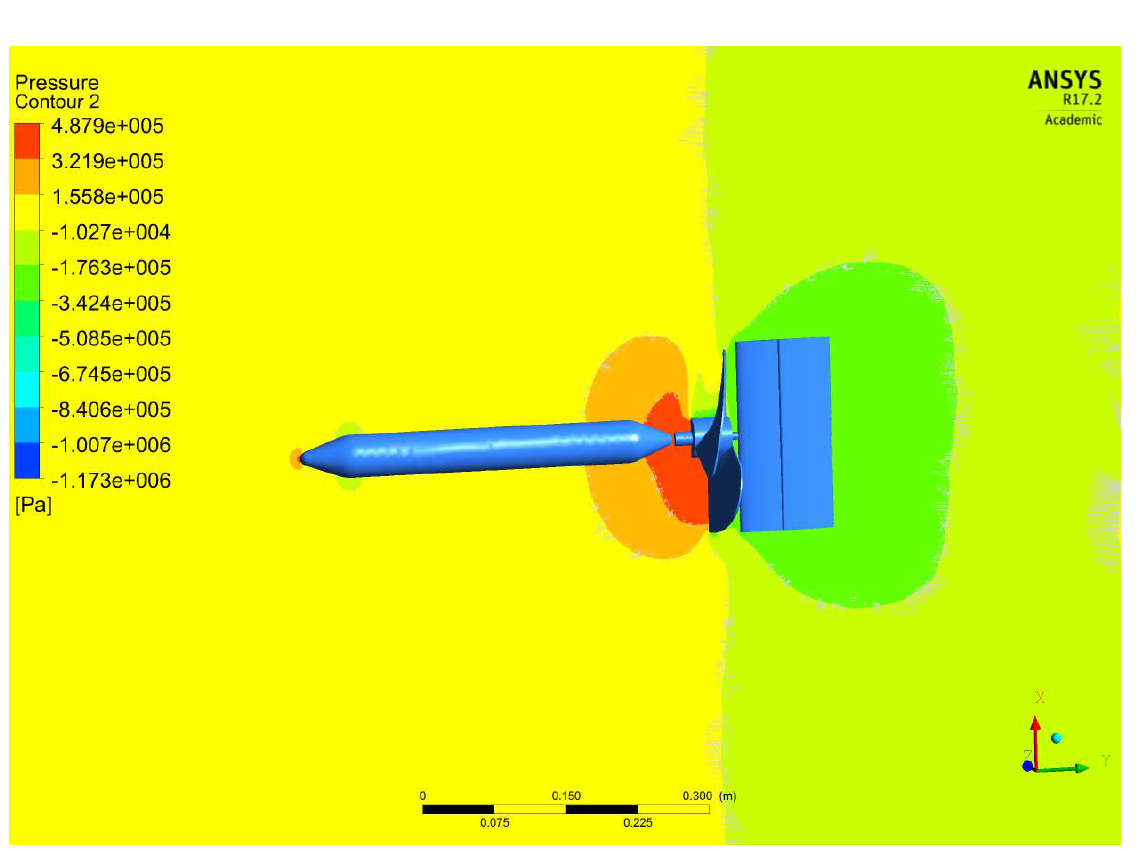
Figure 30. A systematic representations of hydrodynamic pressure distribution on the body of US.